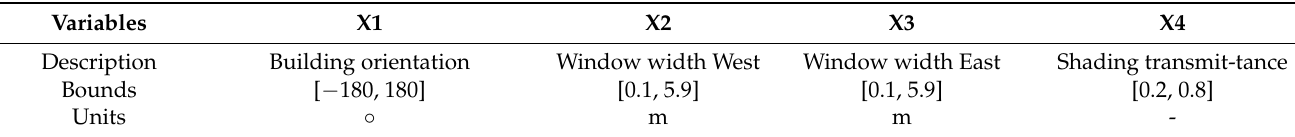
Figure 4. Building model of BEO problem for a simple office building [34]. Table 1. The modest office building ’ s decision factors.